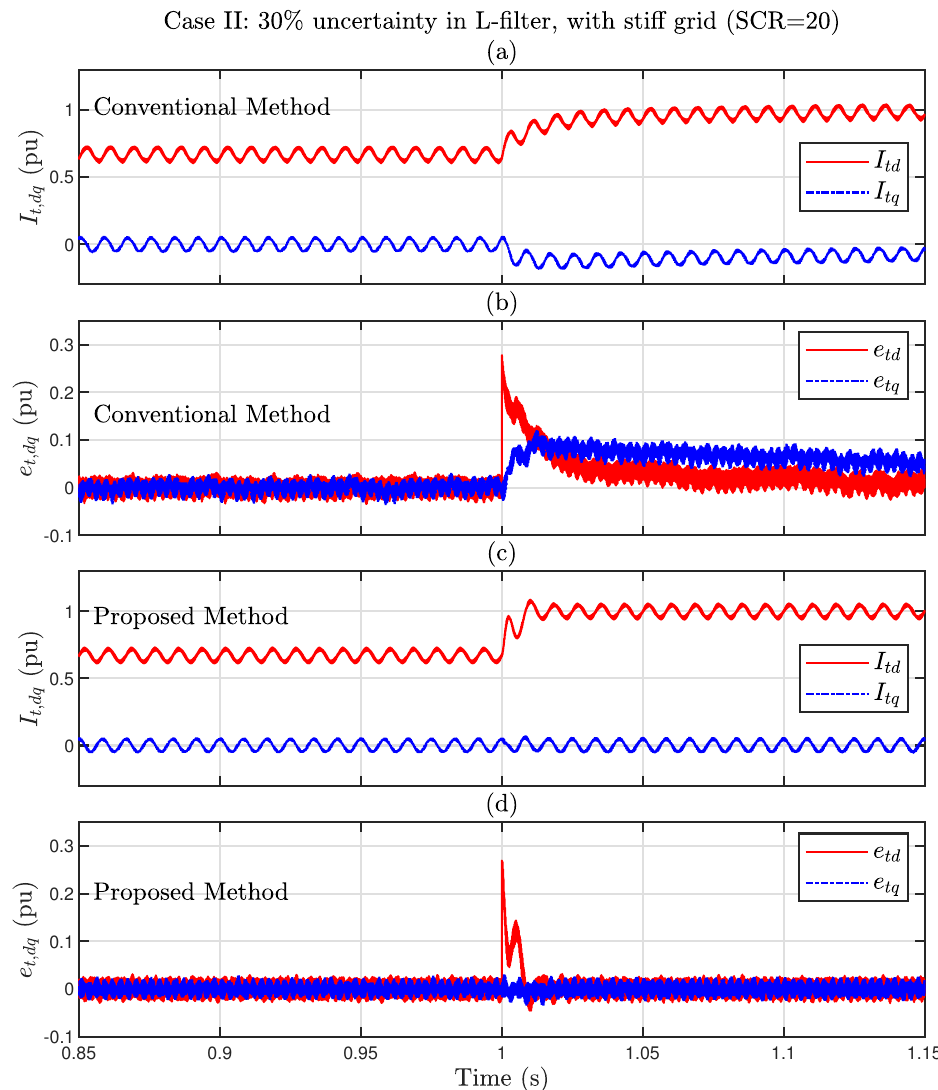
Figure 17. Comparison of the results for Case II: dq components of the inverter currents ( I t , dq ) and error signals ( e t , dq ): ( a , b ) conventional method, and ( c , d ) proposed